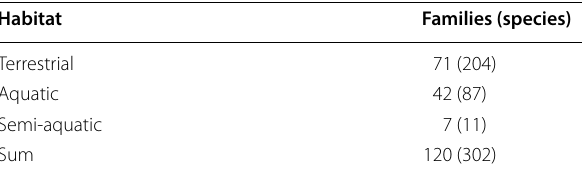
Table 1 Vertebrate taxa bearing neoplastic incidents, categorized according to their habitat Habitat Families